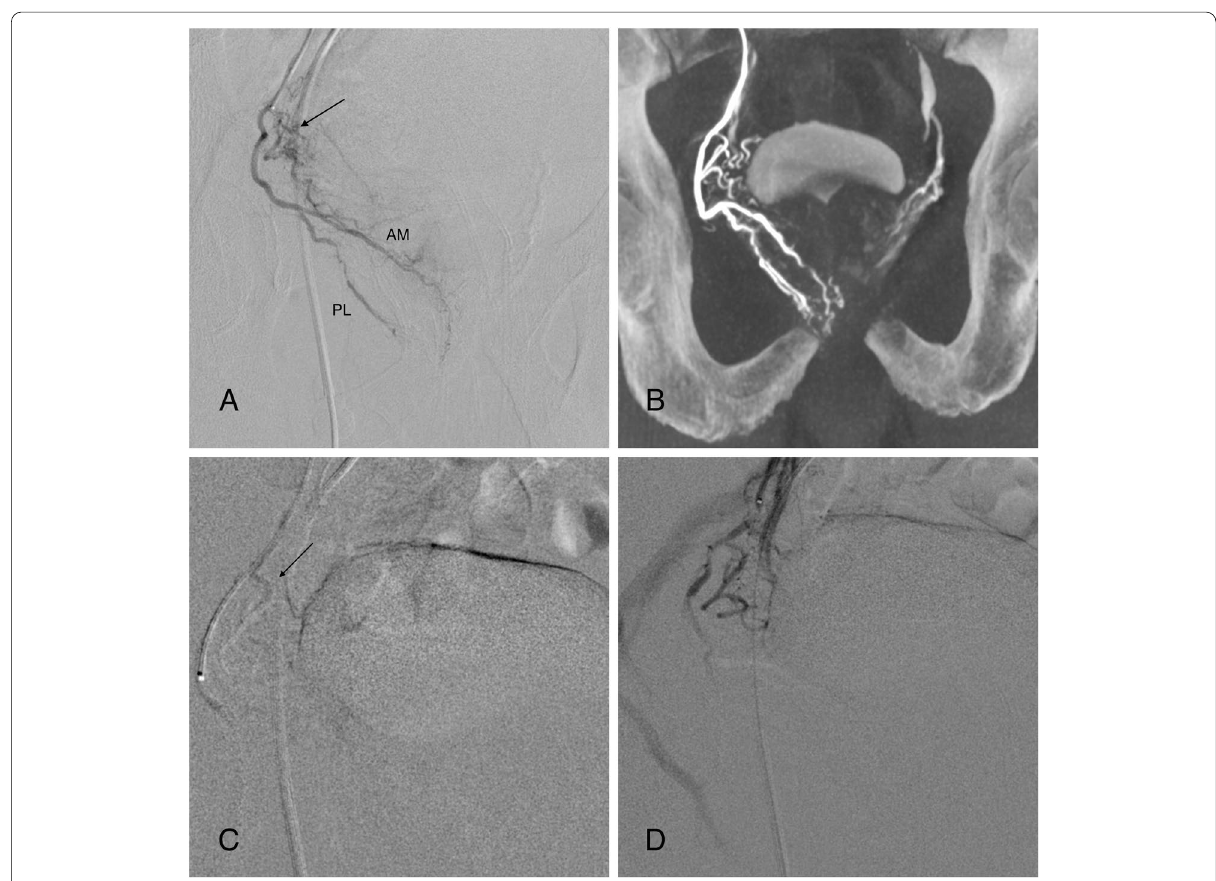
Fig. 2 A Selective right prostatic artery DSA in oblique view showing the normal posterolateral (PL) and anteromedial (AM) prostatic branches. Cranially, a large branch to the bladder was also observed (arrow). B Intraprocedural Cone Beam CT in coronal view confirming the findings seen in DSA. C DSA while microspheres were injected demonstrating reflux to the bladder branch (arrow). D Final DSA after embolization showing devascularization of the prostatic branches and preservation of the bladder arterial